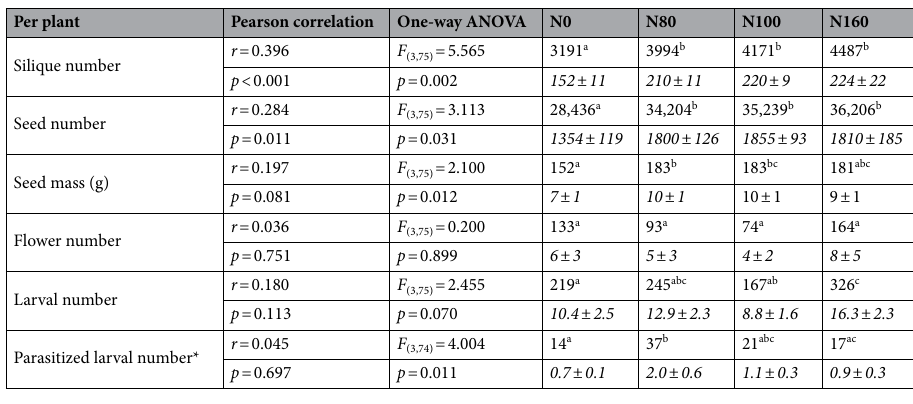
Table 2. One-way ANOVA and Pearson correlation test results for the effects of nitrogen fertilization on Brassica napus yield and Brassicogethes aeneus larval abundance and their parasitized number. Plant traits were calculated at harvest date and insects represent cumulative data up to the harvest. Nitrogen impact on the number of parasitized B. aeneus larvae was tested with ANCOVA. Significantly distinct ( p < 0.05) fertilization groups by Fisher LSD (Least Significant Difference) marked with different letters (Post Hoc comparison). N0- N160—fertilization treatments (kg ha -1 N). The number of replicates in each treatment was: N0 = 21, N80 = 19, N100 = 19, N160 = 20. r represents Pearson correlation coefficients ( n = 79 plants). The average values and standard errors are in italics. *Total number of larvae was taken as a